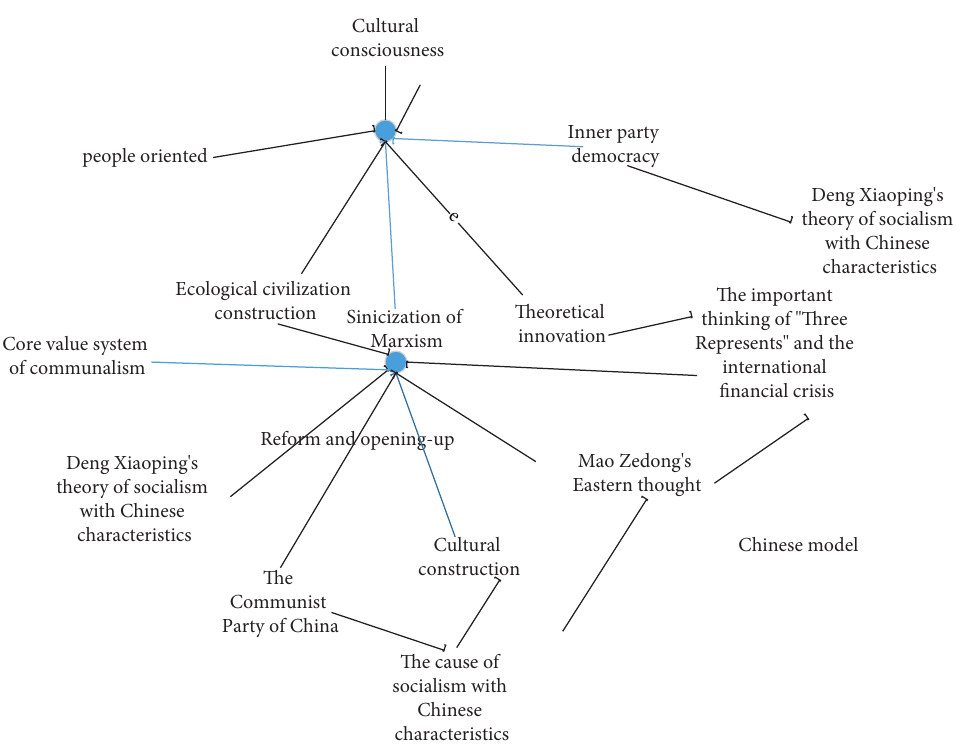
Figure 1: Keyword mapping of Marxist theory